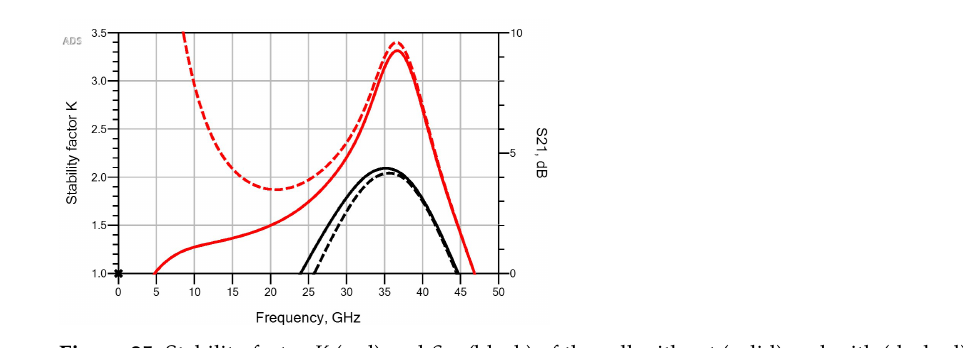
Figure 25. Stability factor K (red) and S 21 (black) of the cell without (solid) and with (dashed) the SN of Figure5b.